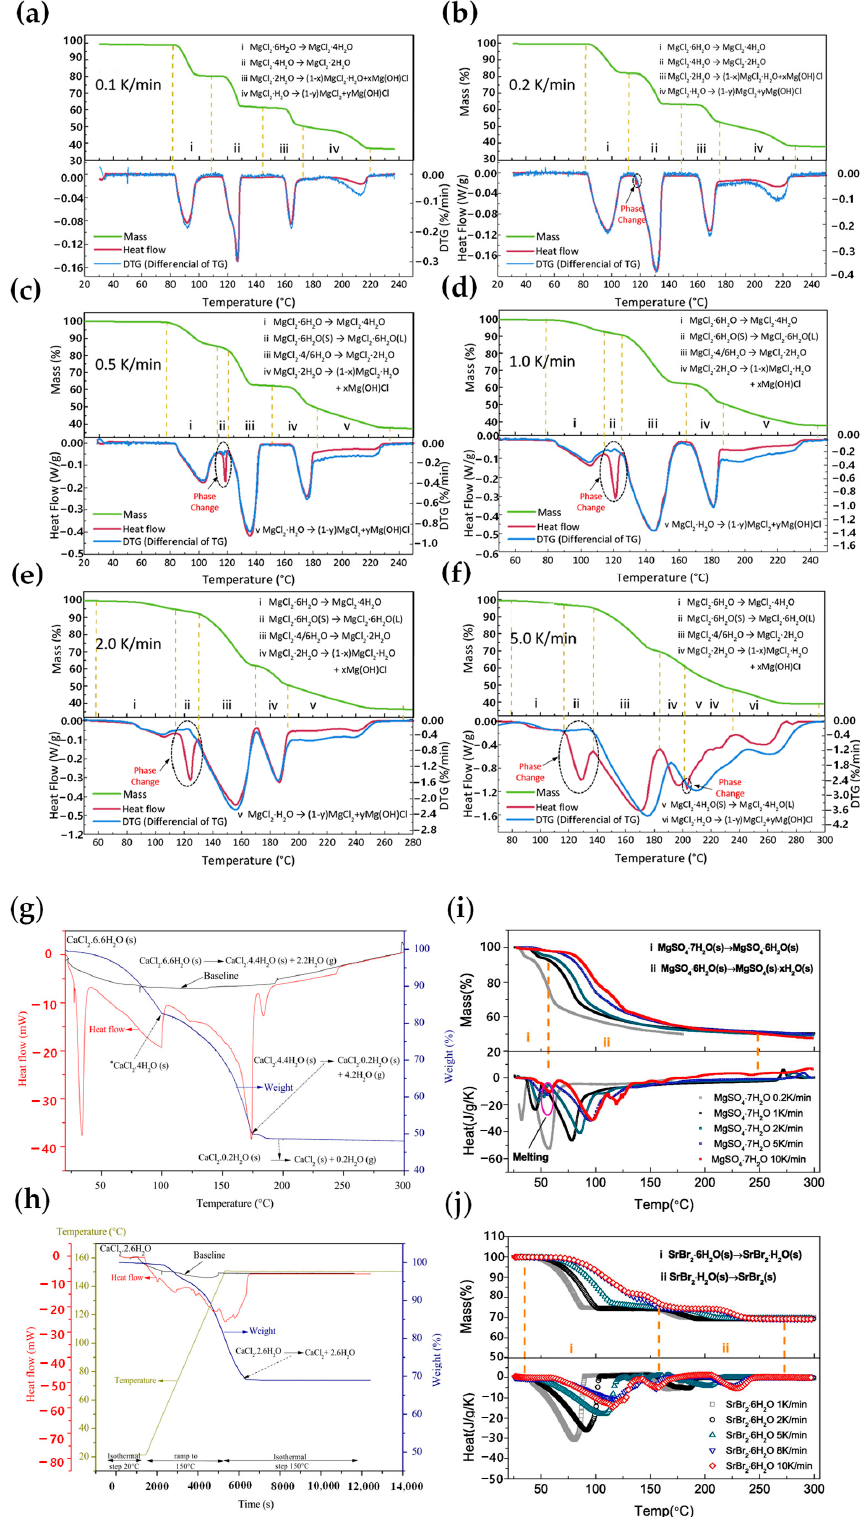
Figure 10. Heat flow curves: ( a – f ) MgCl 2 · 6H 2 O [49]; ( g , h ) CaCl 2 · 6H 2 O [65]; ( i ) MgSO 4 · 7H 2 O [51]; and ( j ) SrBr 2 · 6H 2 O [51]: Reprinted with permission from Ref. [49]. Copyright © 2020 Elsevier B.V. All rights reserved; permission from Ref. [64]. Copyright © 2020 Elsevier B.V. All rights reserved; permission from Ref. [51]. Copyright © 2019 Elsevier B.V. All rights